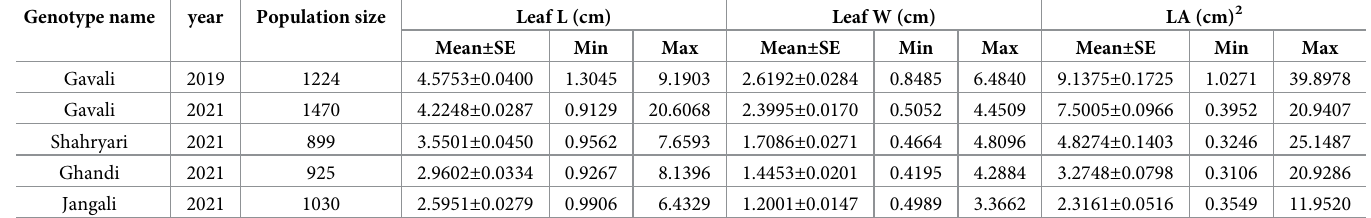
Table 2. Descriptive statistics of leaf Length (L), width (W) and area (LA) of three greengage genotypes with local names Gavali, Ghandi and Shahryari and a myro- balan plum with the local name of Jangali. Genotype name